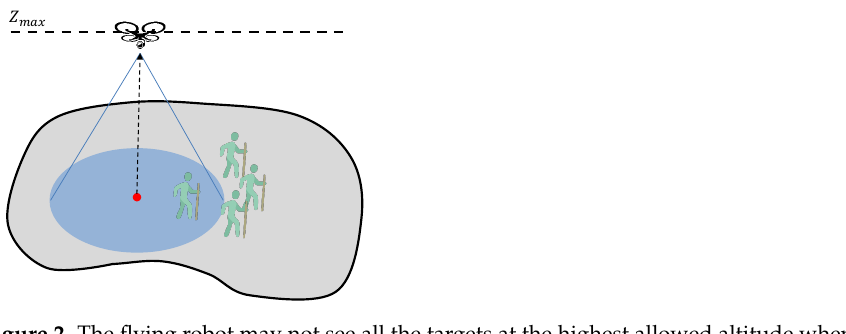
Figure 2. The flying robot may not see all the targets at the highest allowed altitude when it launches from the initial position shown as the red